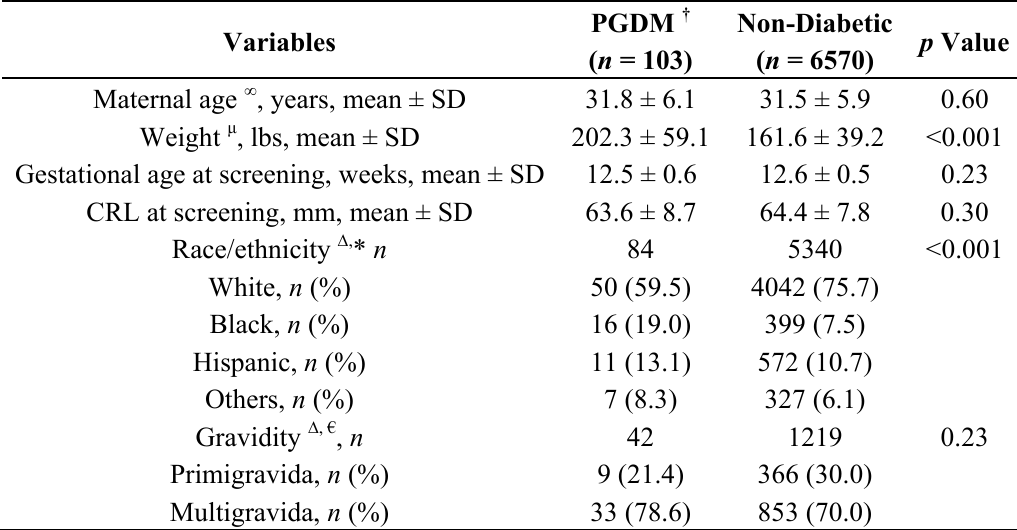
Table 1. Descriptive demographics of study